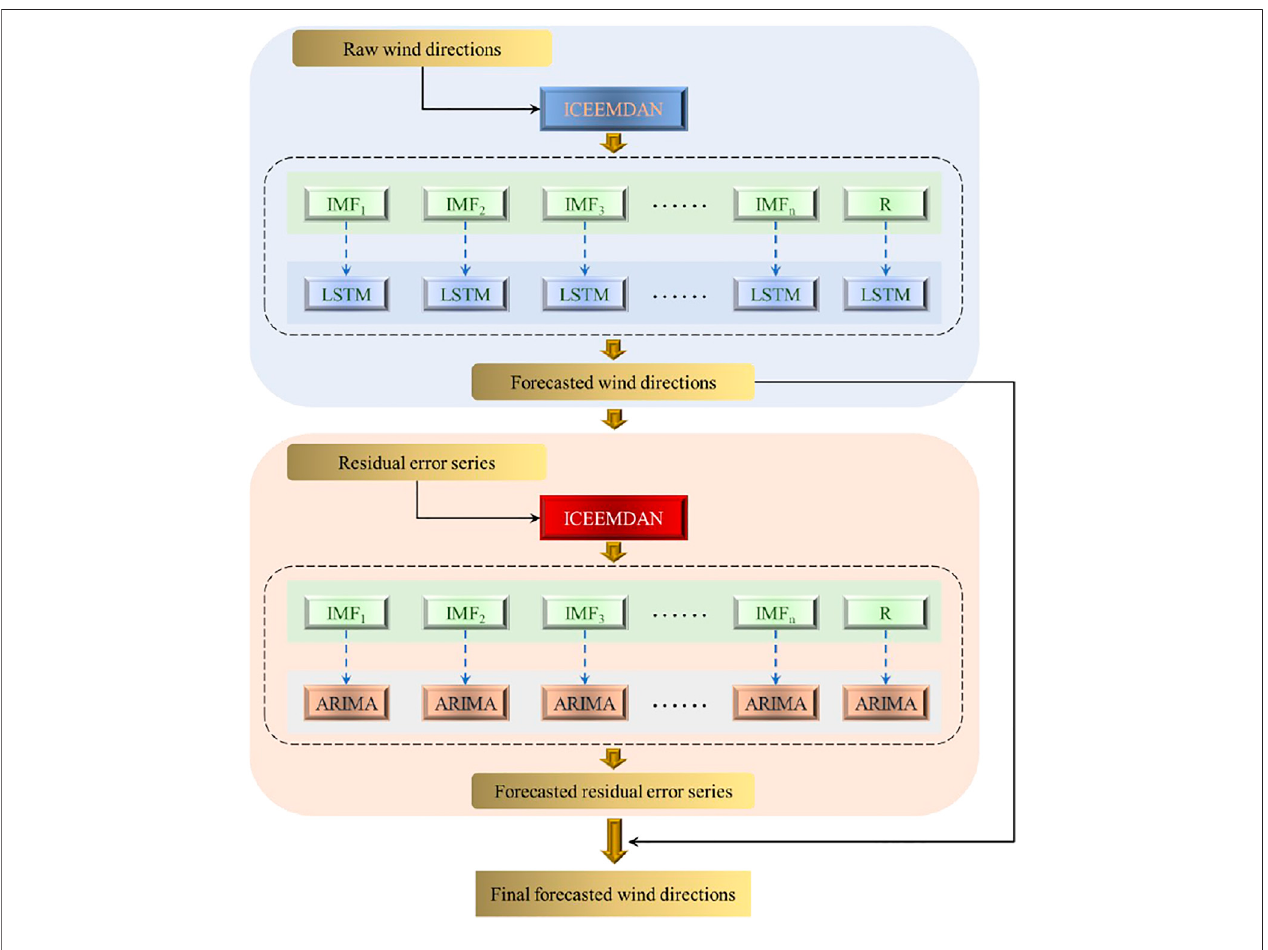
FIGURE 4 | Diagrams of ICEEMDAN modules.